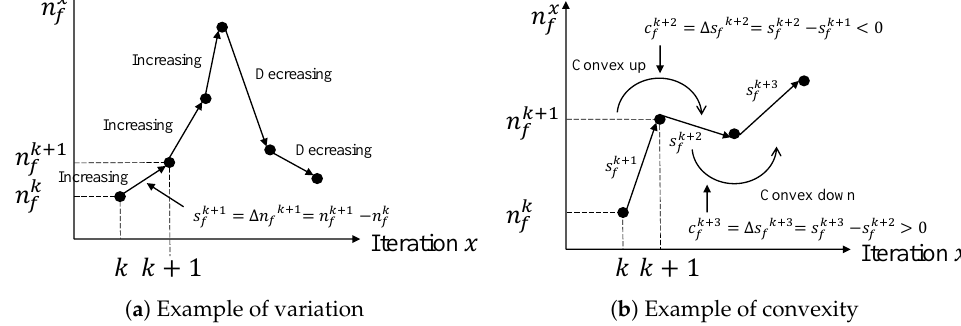
Figure 3. Metrics with respect to the number of frontiers used to determine workload state. Observation 1. As s f increases, the cost of the push phase also